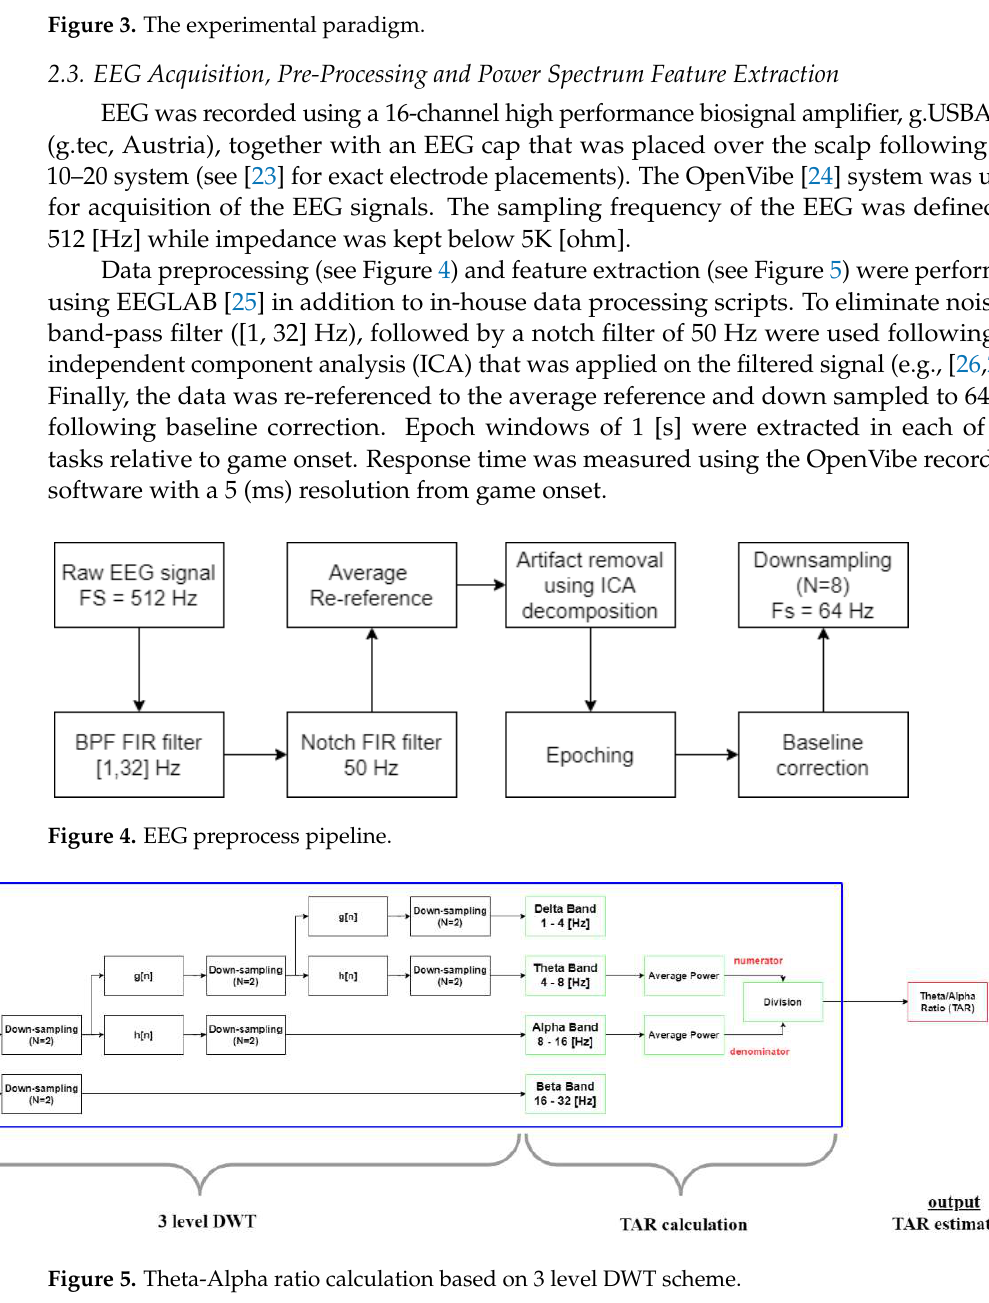
Figure 3. The experimental paradigm.